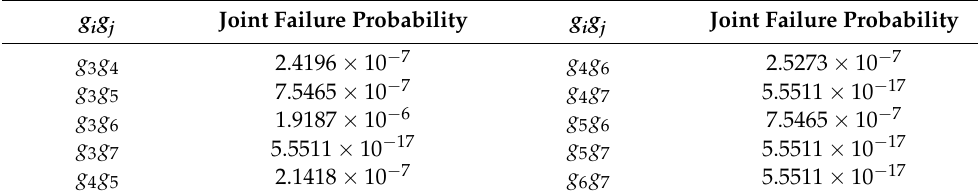
Table 7. Two-dimensional joint failure probabilities for each combination of failure